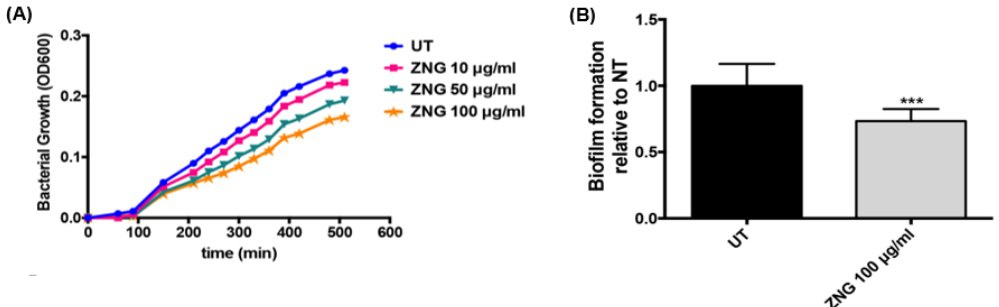
Figure 9. ( A ) Bacterial growth of S. mutans cells in media containing different concentrations of ZNGs